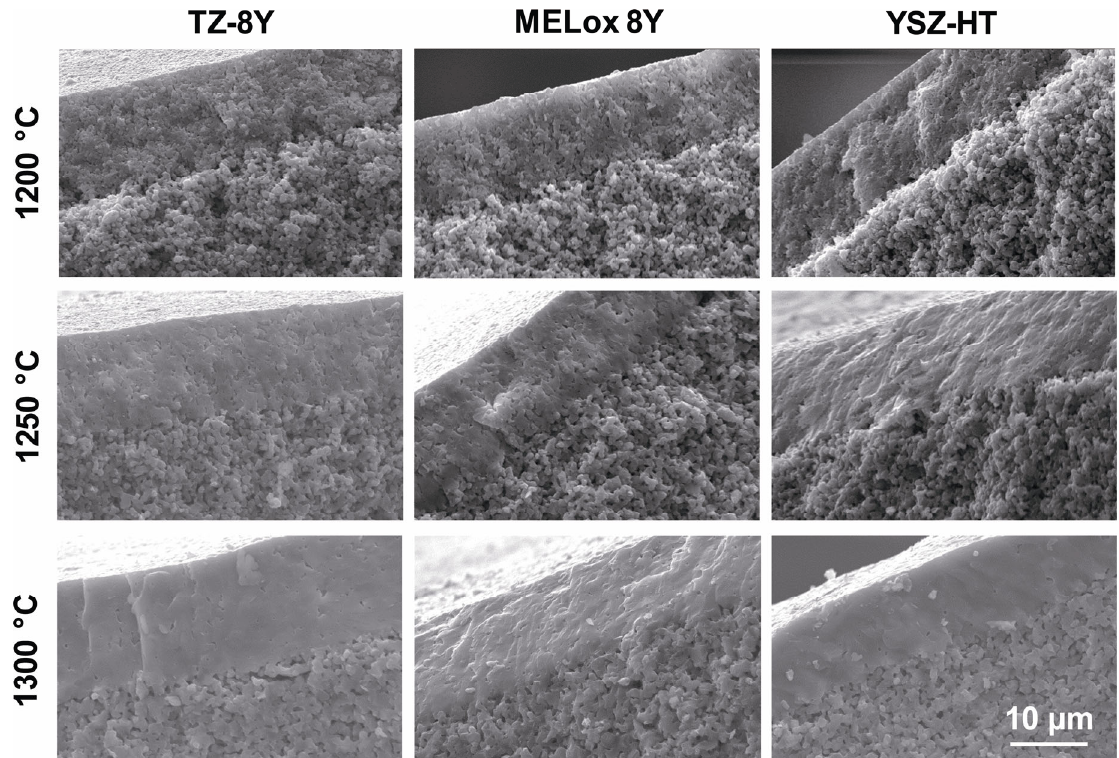
Fig. 8 Cross-sectional SEM images of the thin-film YSZ electrolytes co-sintered with NiO–YSZ anode supports at different temperatures. The scale bar applies to all the